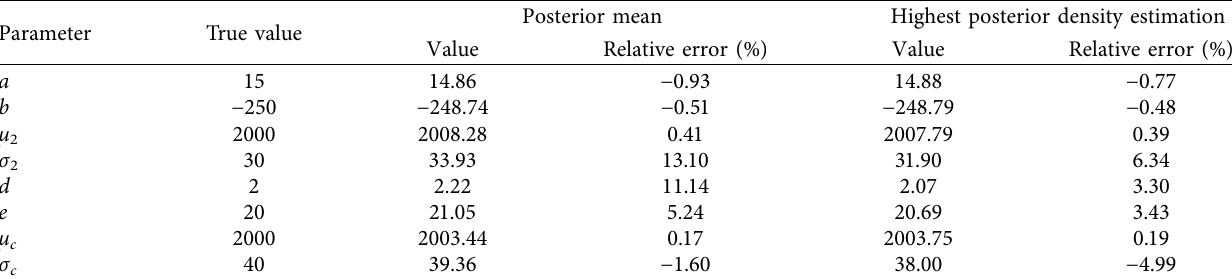
Figure 14: Posterior PDFs of the epistemic uncertain parameters and hyperparameters. Table 4: Identification errors of the epistemic uncertain parameters and hyperparameters.